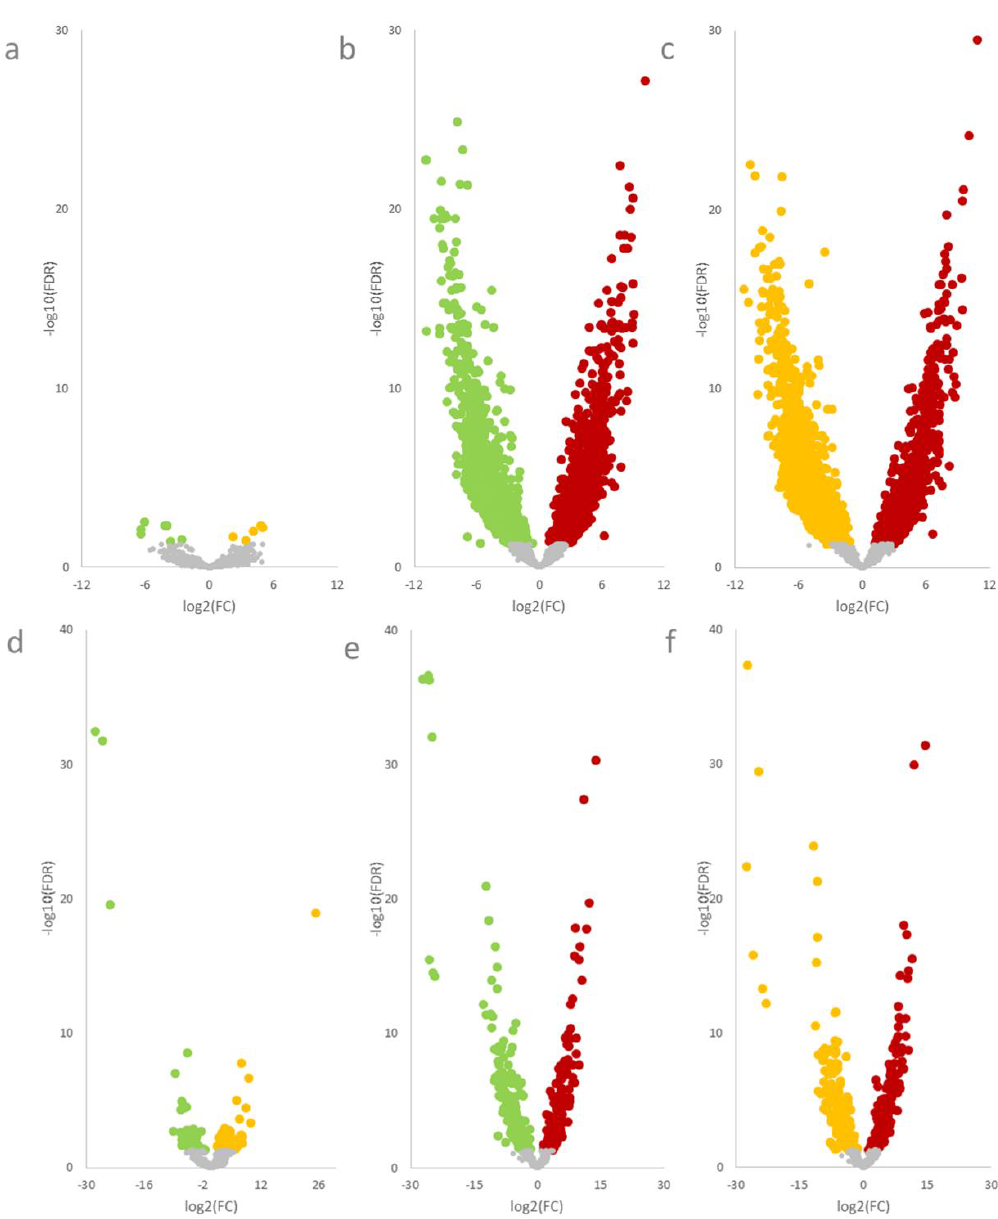
Figure 4. Volcano plots of di ff erential bacterial ( a – c ) and fungal ( d – f ) operational taxonomic unit (OTU) abundance analysis as calculated by DESeq 2.0 according to the site ( a and d —Eastnor vs. Hatchlands; b and e —Eastnor vs. Richmond; c and f —Hatchlands vs. Richmond). Fold change FDR corrected p -values are plotted for each OTU. Significantly di ff erent taxa (FDR-corrected p < 0.05) are coloured according to site: Eastnor—green, Hatchlands—yellow, Richmond—red.